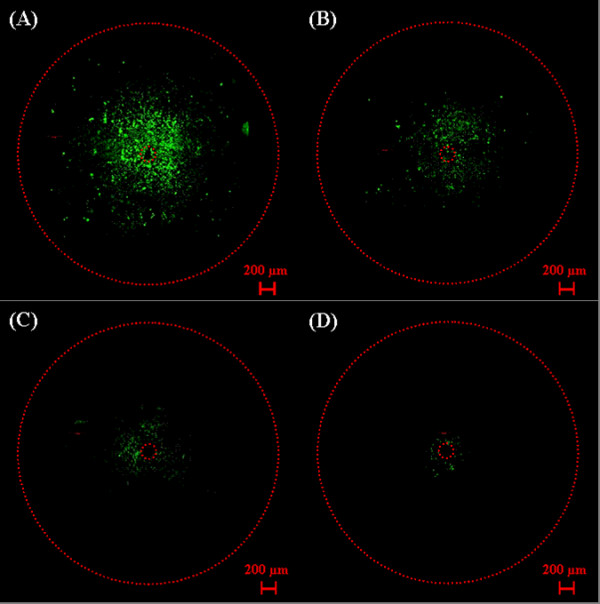
Fluorescence images of U251 glioblastoma cells [(A) and (C)] and keratoacanthoma cells [(B) and (D)] after nanoelectropulse exposure (1000, 10 kV, 15 ns pulses at 50 Hz) with the flat-cut cable electrode at a distance of < 25 μm [(A) and (B)] and 200 μm [(C) and (D)], respectively.